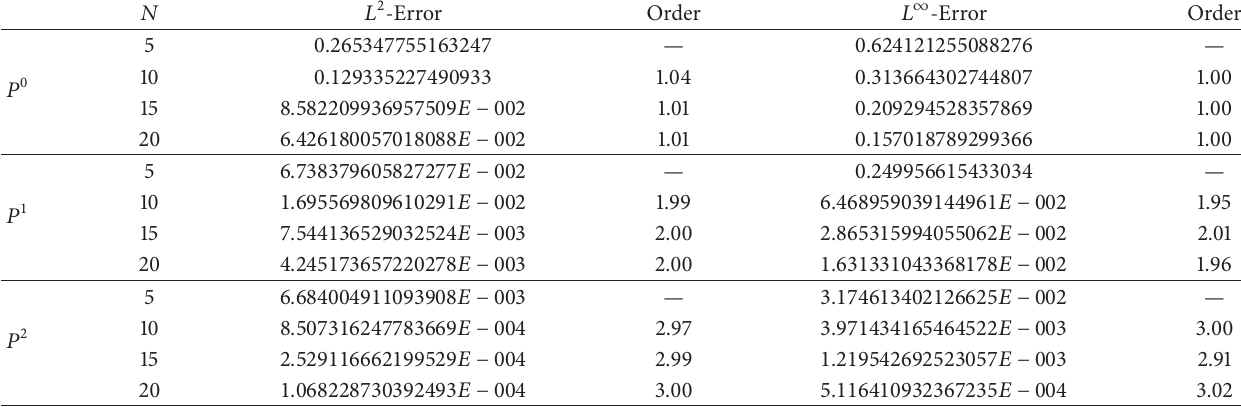
Table 9: Spatial accuracy test for the fractional order equation with the forcing term (42). 𝛼 = 0.9 , 𝑀 = 10 4 , 𝑇 = 1 . 𝑁 𝐿 2 -Error Order 𝐿 ∞ -Error Order 5 0.265347755163247 — — 10 0.129335227490933 1.04 1.00 𝑃 0